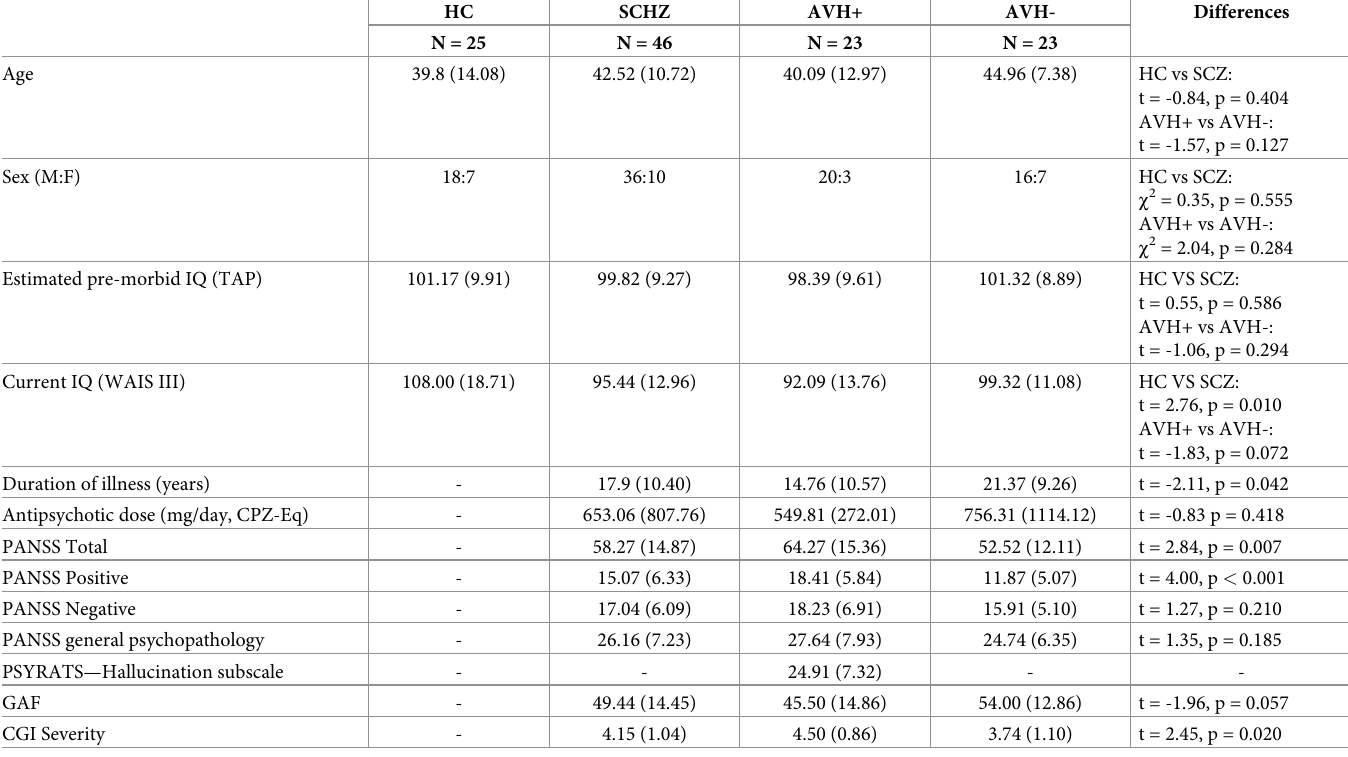
Table 1. Demographic and clinical data from the final samples.